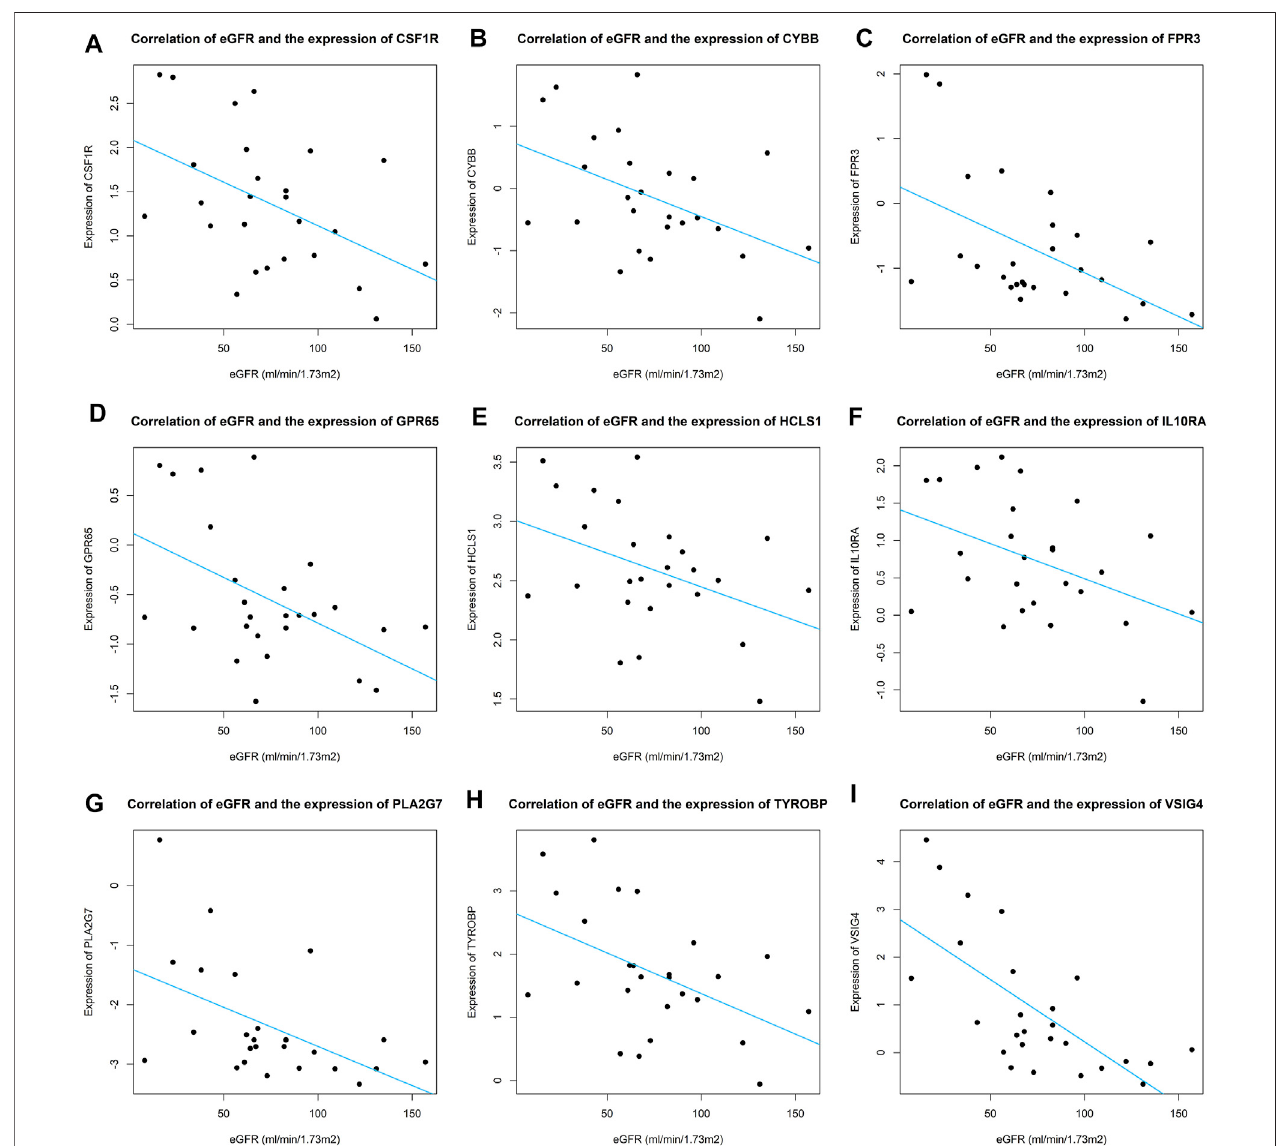
FIGURE 8 | Correlation of eGFR and expression of real hub genes across IgAN patients. (A – I) Correlation of eGFR and expression of CSF1R, CYBB, FPR3, GPR65, HCLS1, IL10RA, PLA2G7, TYROBP, and VSIG4.